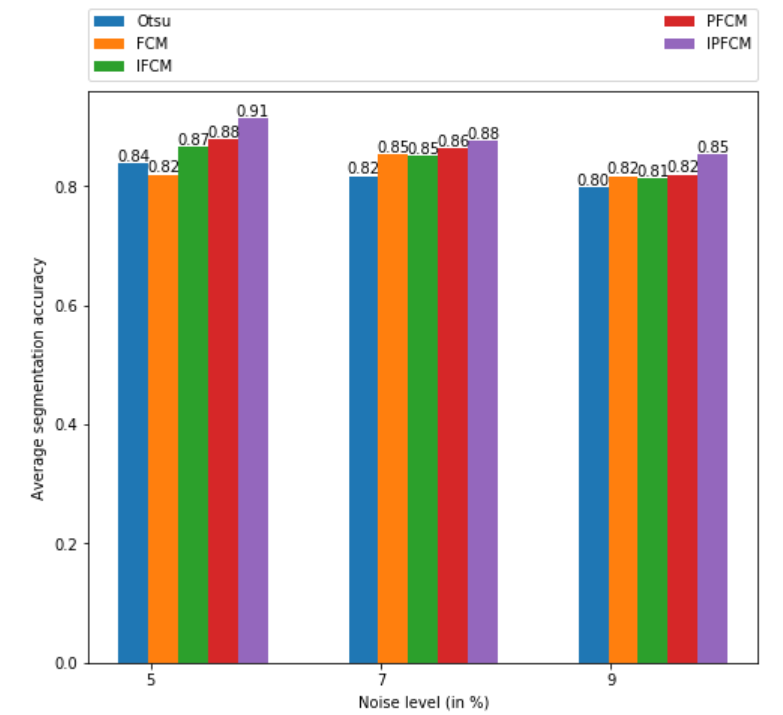
Figure 5. Average segmentation accuracy for Mammography Image Analysis Society (MIAS) images with different noise level chart.